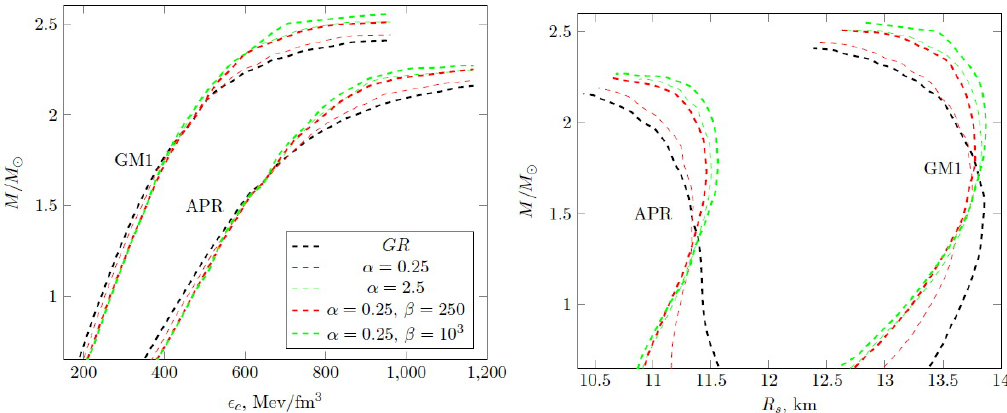
Figure 1. Gravitational mass versus central density (left panel) and radius (right panel) using equations of state (EoS) GM1 and APR for some values of α and β (in units of r 2 g where r g is gravitational radius of Sun) in comparison with general relativity ( α = 0). For mass of axion field, hereinafter, we take value m a = 0.1 in units of r − 1 g .